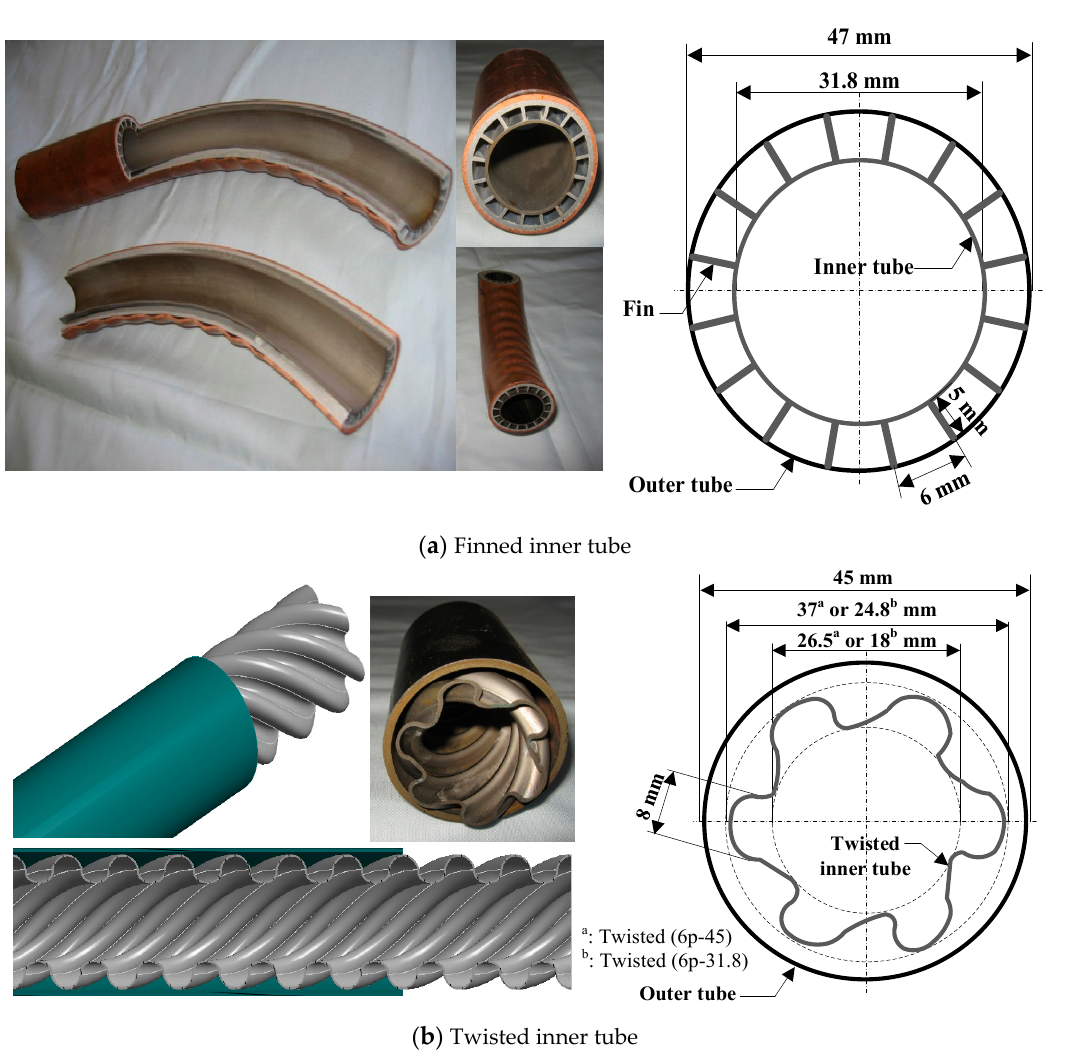
Figure 4. Two types of double pipe heat exchangers for the automatic cleaning system. Table 1. Specifications of tubes for double pipe heat exchangers.